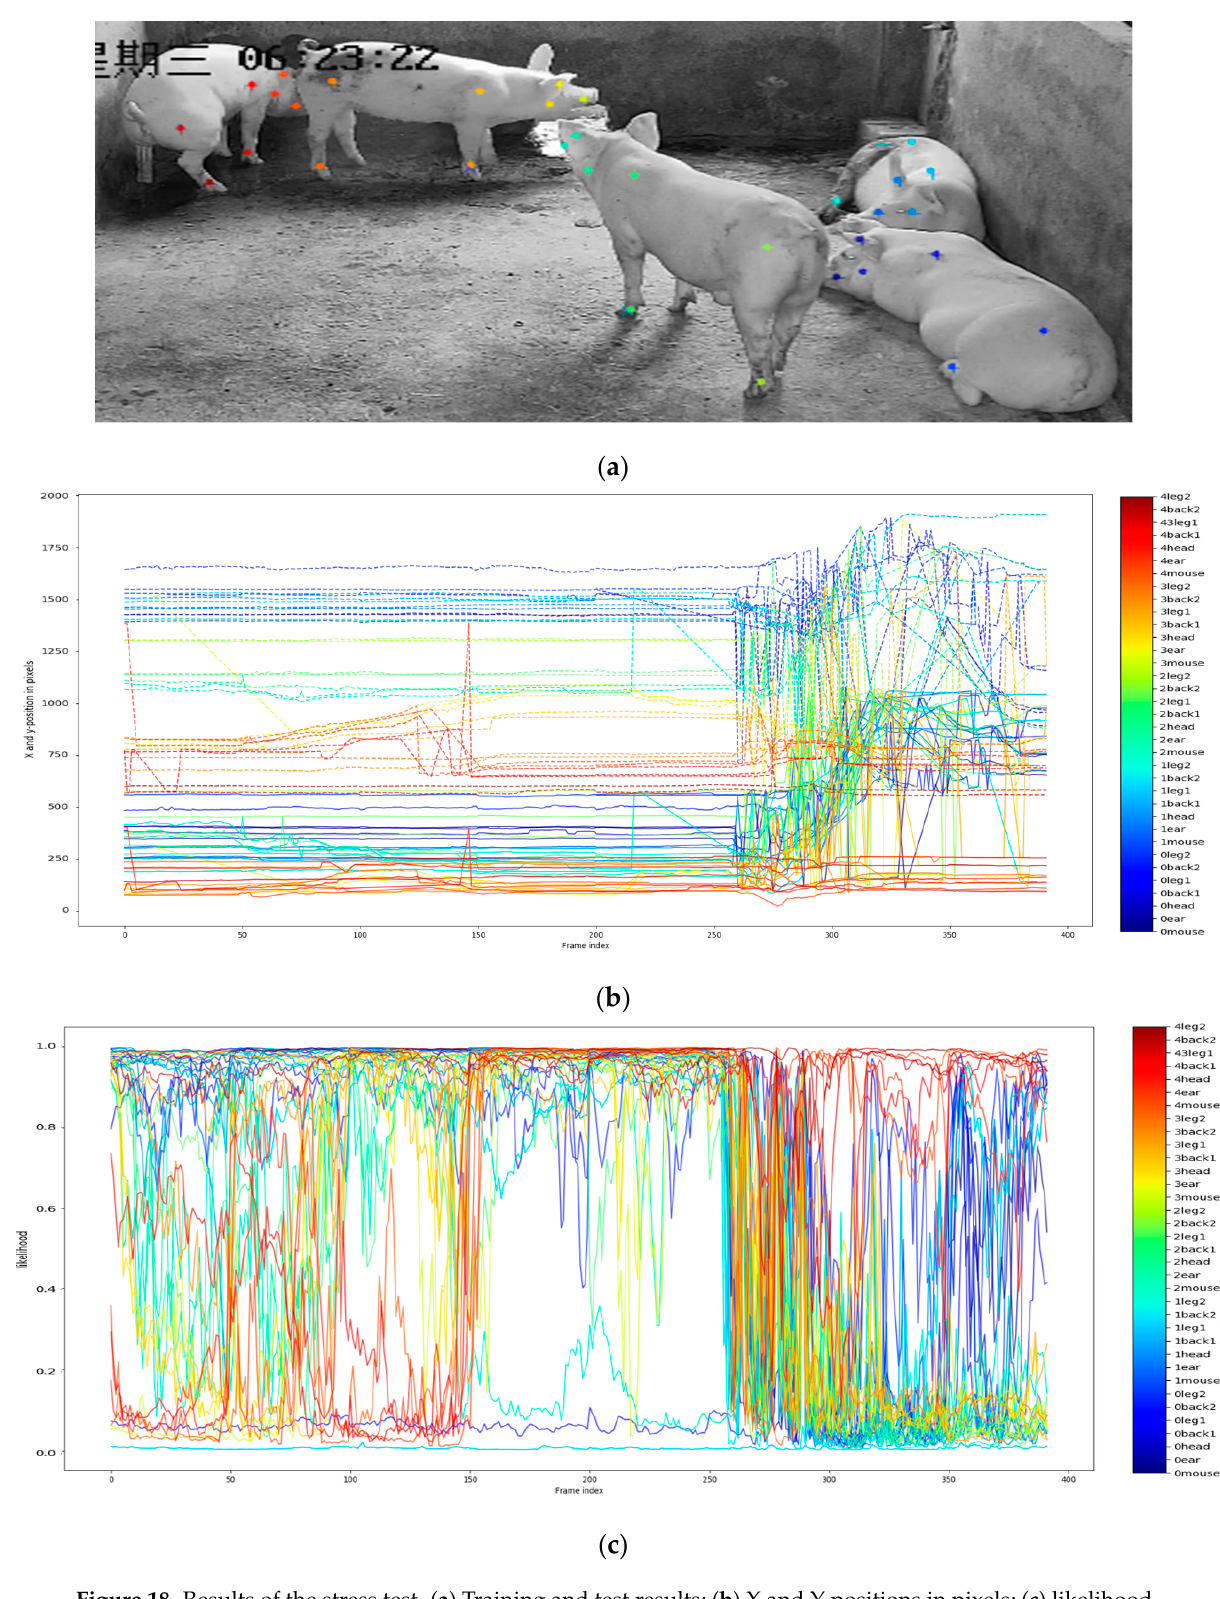
Figure 18. Results of the stress test. ( a ) Training and test results; ( b ) X and Y positions in pixels; ( c ) likelihood. According to the above results, this paper compared the number and amplitude of abnormal trajectory drift between the improved DLC-KPCA algorithm and the traditional DLC algorithm.